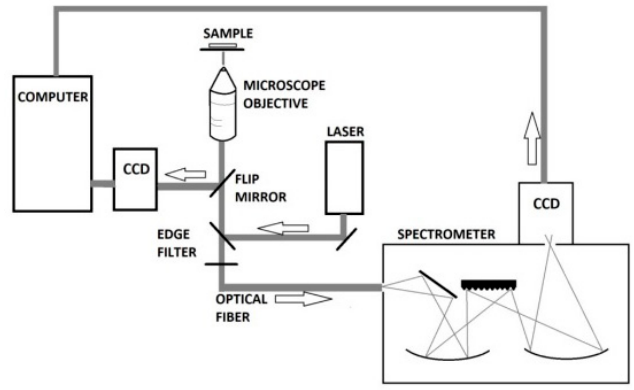
Figure 3. Schematic of the setup, starting with a computer coupled to the spectrometer that was fiber-optically coupled to the microscope.